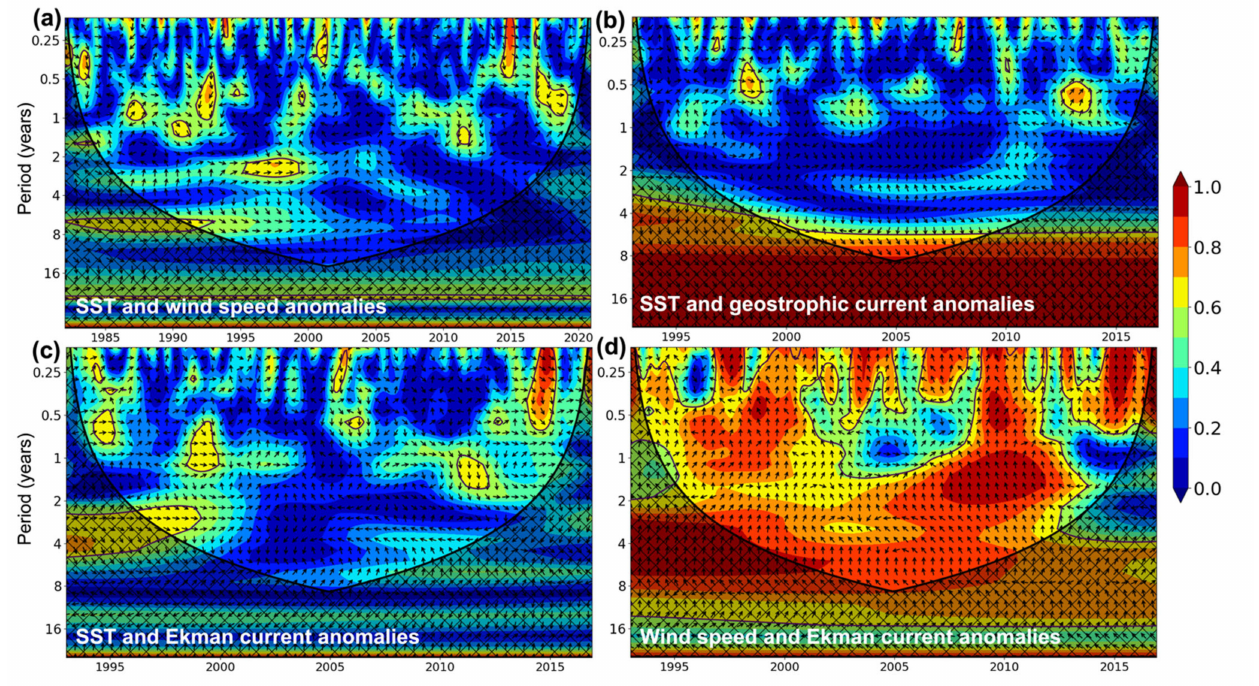
Figure 8. The wavelet coherence between standardized monthly anomalies of ( a ) Sea Surface Tem- perature (SST) and wind speed, ( b ) SST and geostrophic current speed, ( c ) SST and Ekman current speed, and ( d ) Wind speed and Ekman current speed. Note the different time series lengths. The relative phase relationships are shown as arrows (with in-phase pointing right, anti-phase pointing left). The 95% confidence level regions are highlighted in red and circled by a black contour. The cross-hatched regions are insignificant due to the effect of zero